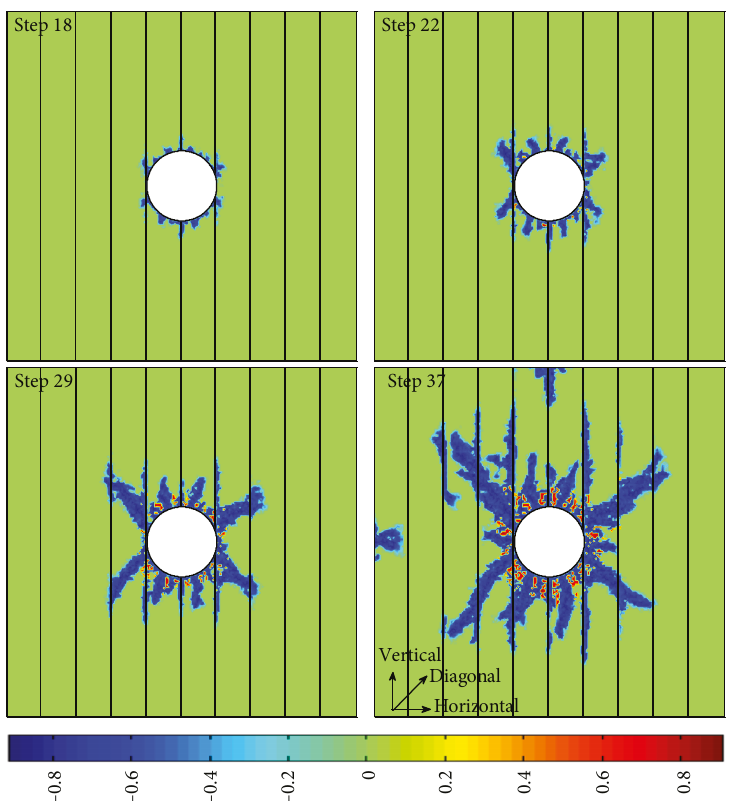
Figure 11: Distribution and evolution of the fracture in the vertical jointed sample.